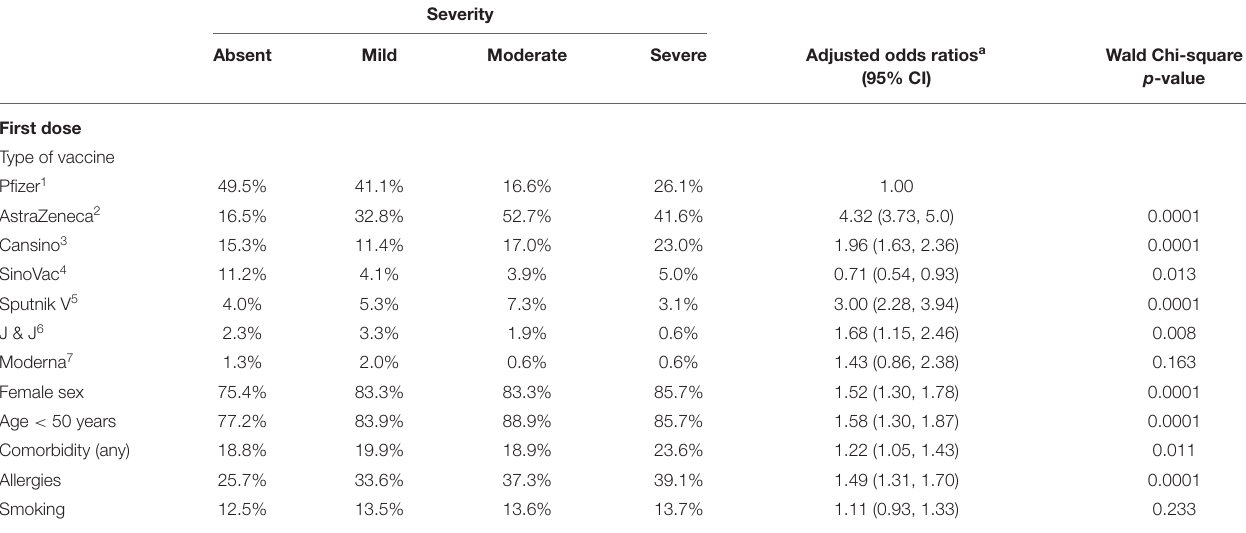
TABLE 6 | Multivariate ordinal regression analyses of factors associated to the severity of side effects in Mexican population, August to September 2021.